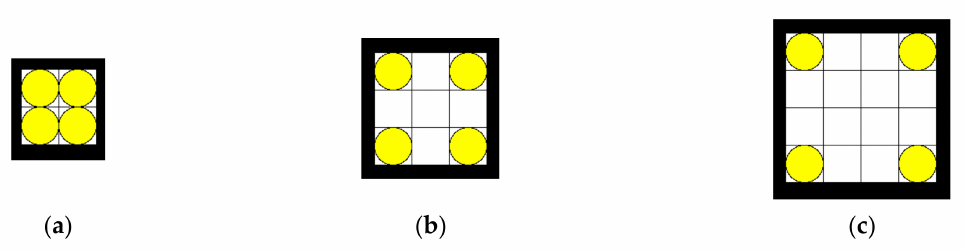
Figure 2. Example layouts to demonstrate computational complexity: ( a ) 2 × 2, four pick-up/drop-off locations (four pick-up/drop-off locations means there are 12 directed routes between pick-up/drop- off locations to be found); ( b ) 3 × 3, four pick-up/drop-off locations; ( c ) 4 × 4, four pick-up/drop-off locations. The transition between cells is only in directions up, down, left, and